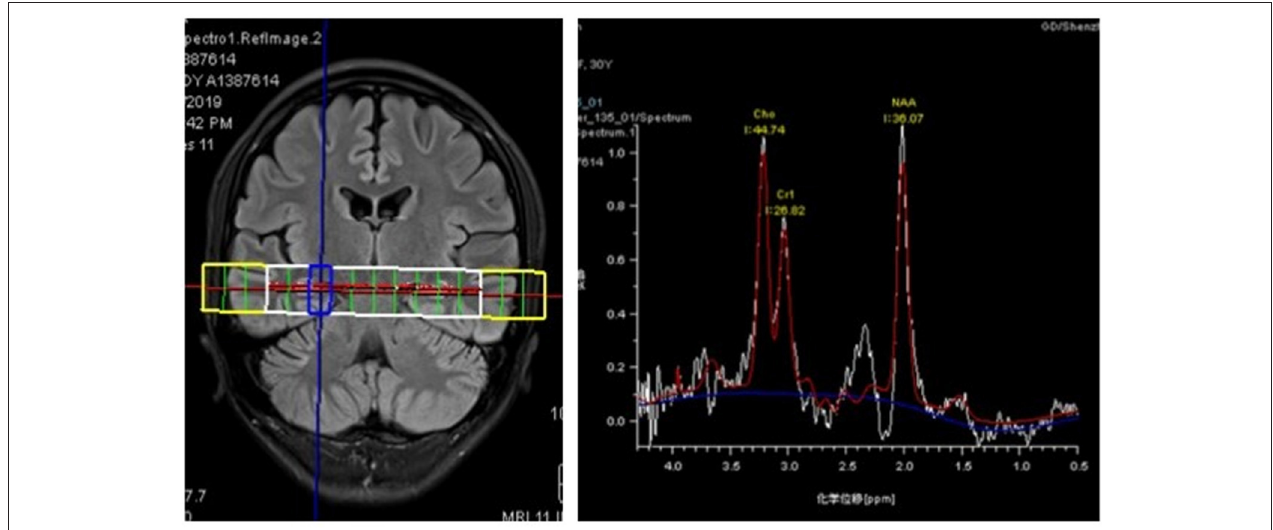
FIGURE 2 | 1 H-magnetic resonance spectroscopy (MRS) images showing an increased Cho/Cr ratio (1.67) in the right hippocampus with a markedly elevated Cho